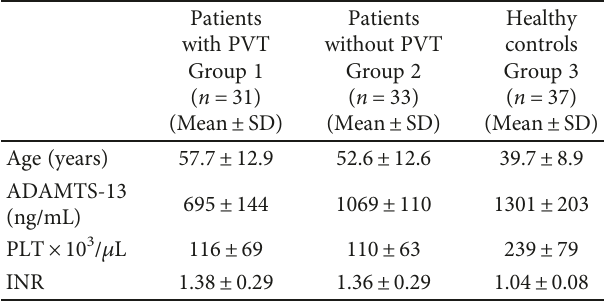
Table 1: Baseline characteristics of the analyzed groups.